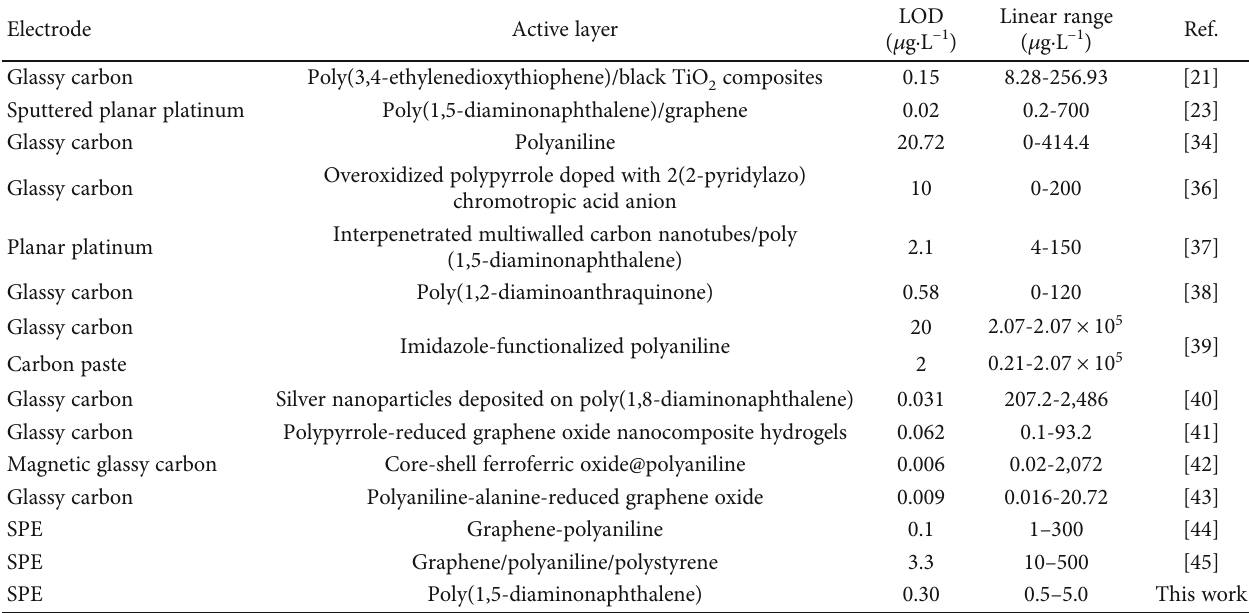
bu ff er (pH 4.5) at bare SPEs (curve (a)) and p(1,5-